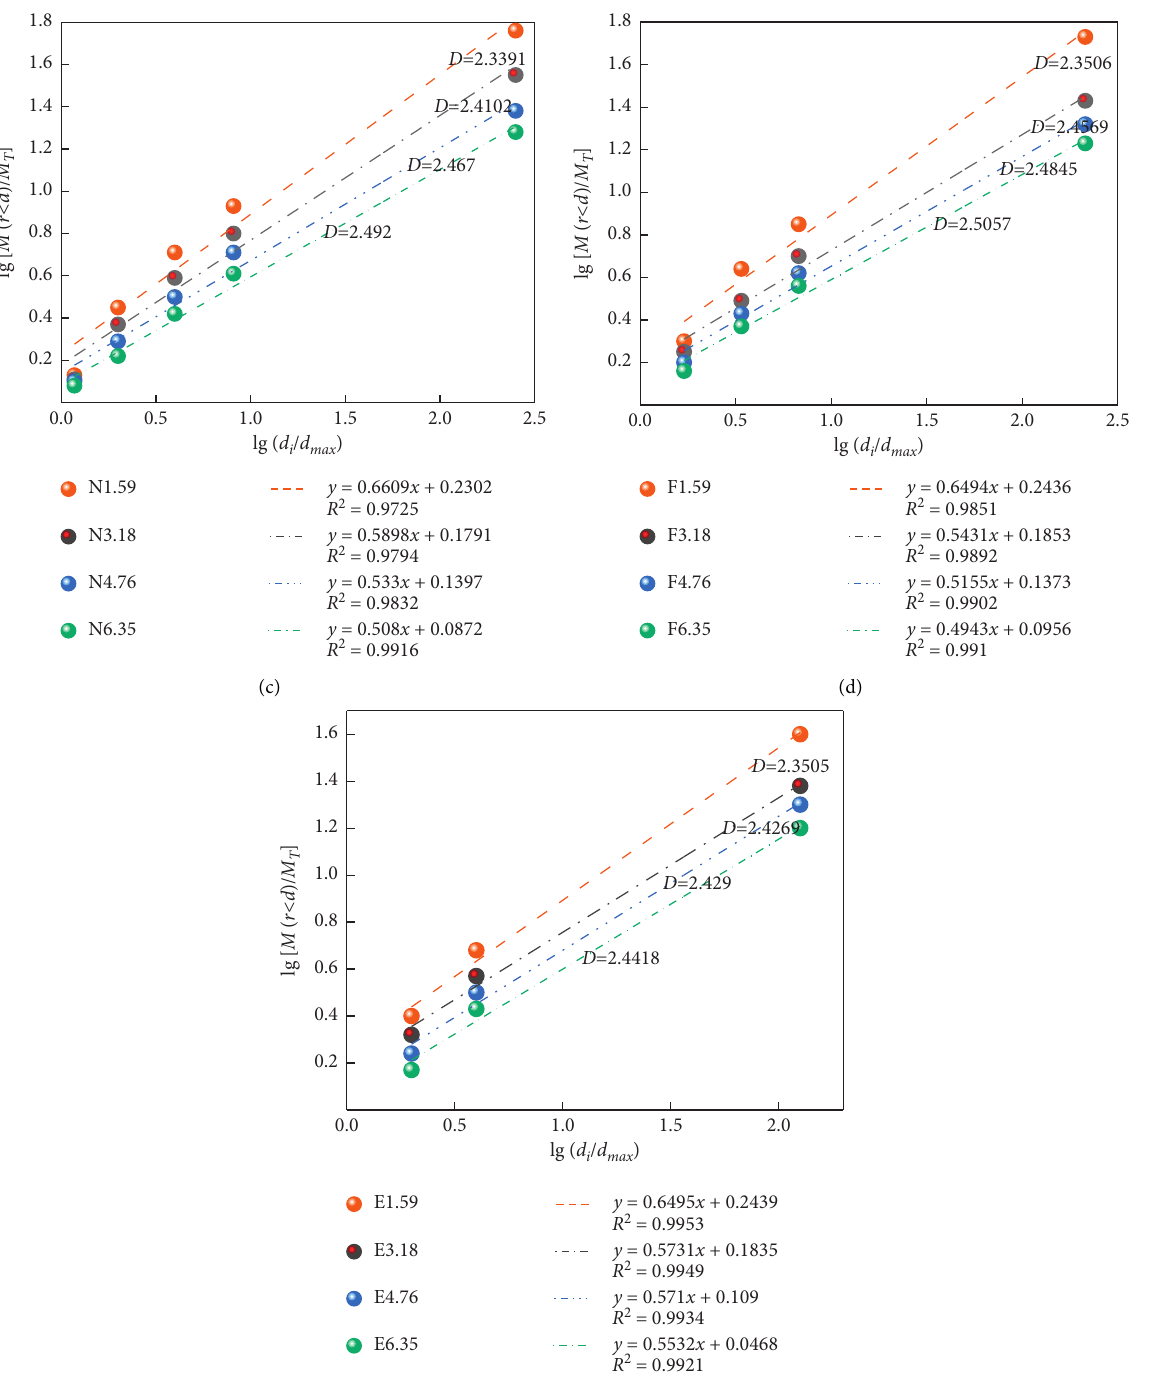
Figure 13: Fractal curve of particle size of recycled aggregate of concrete. (a) 26.5–31.5mm. (b) 19–26.5mm. (c) 16–19mm. (d) 9.5–16mm. (e) 4.75–9.5